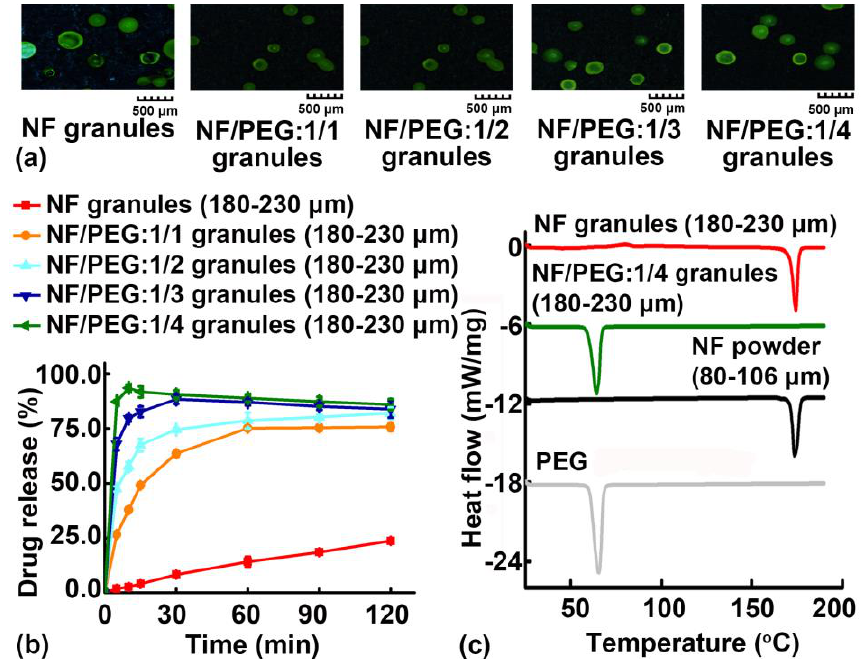
Figure 10. ( a ) Typical morphology observed by stereomicroscope and ( b ) in vitro dissolution profiles of nifedipine (NF)/polyethylene glycol (PEG) granules with different ratios. ( c ) DSC curves of NF granules, NF/PEG: 1/4 granules, NF powder, and PEG.